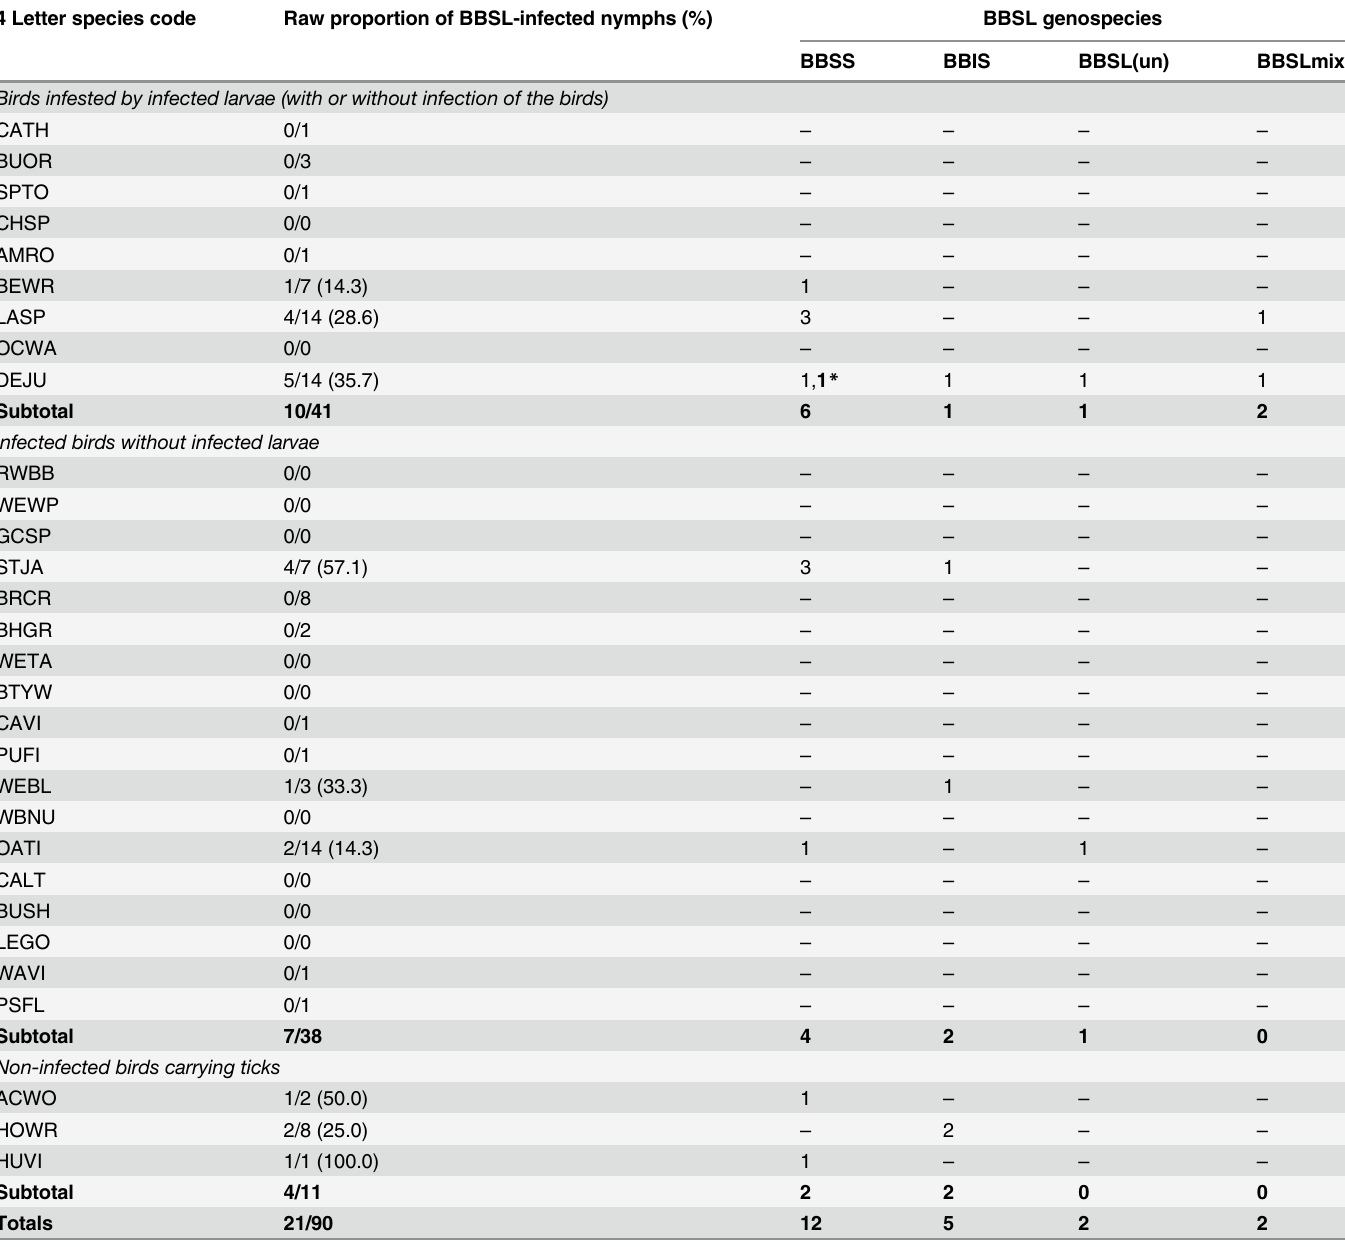
Table 7. Summary of B . burgdorferi s.l. genospecies found in I . paci fi cus nymphs removed from birds.